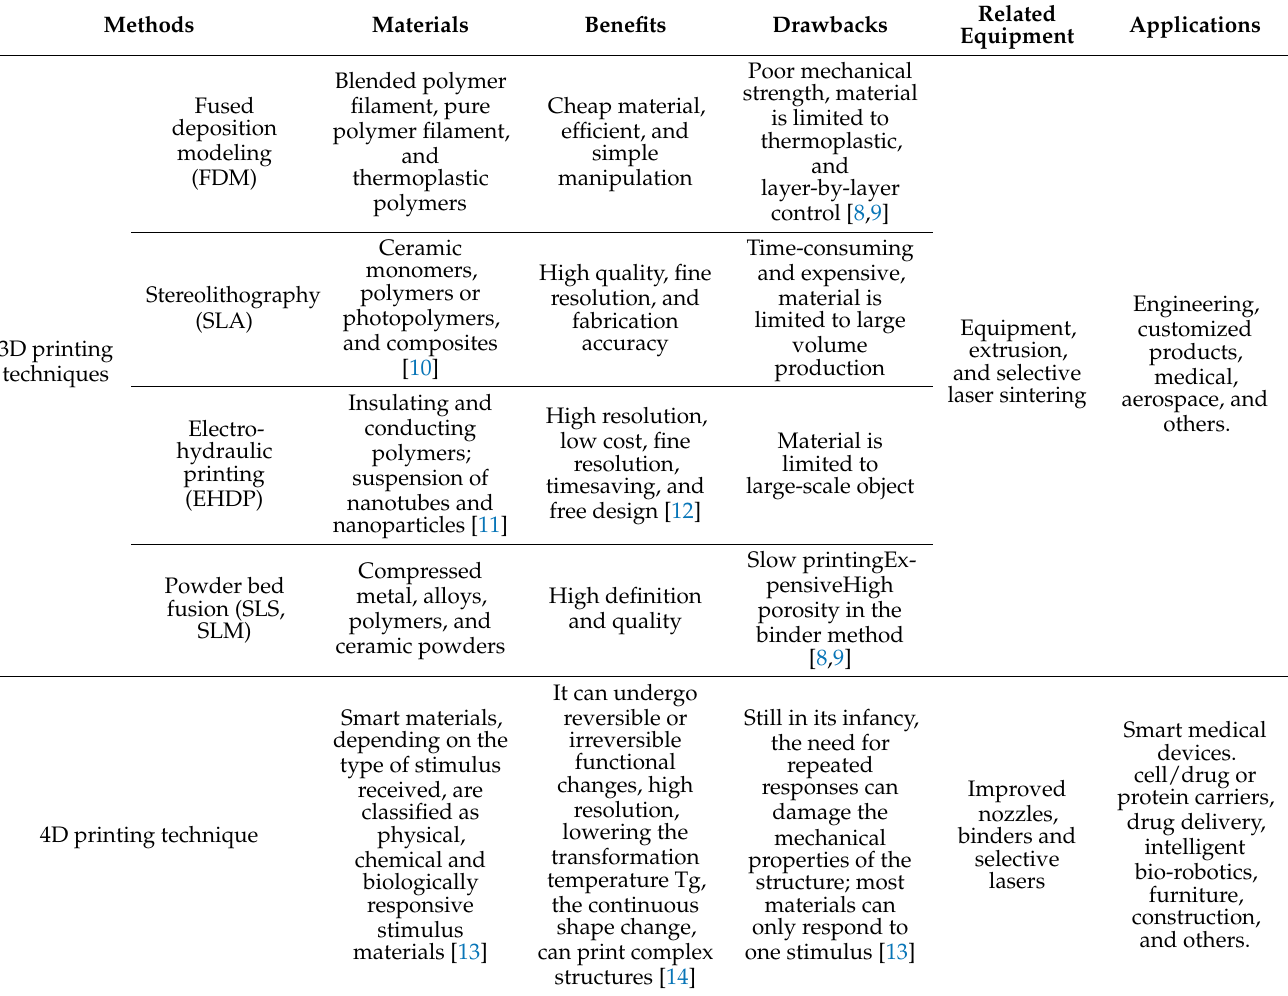
Table 1. Summary of materials, benefits, and drawbacks of 3D and 4D printing techniques. Adapted from References [8,9], with permission from